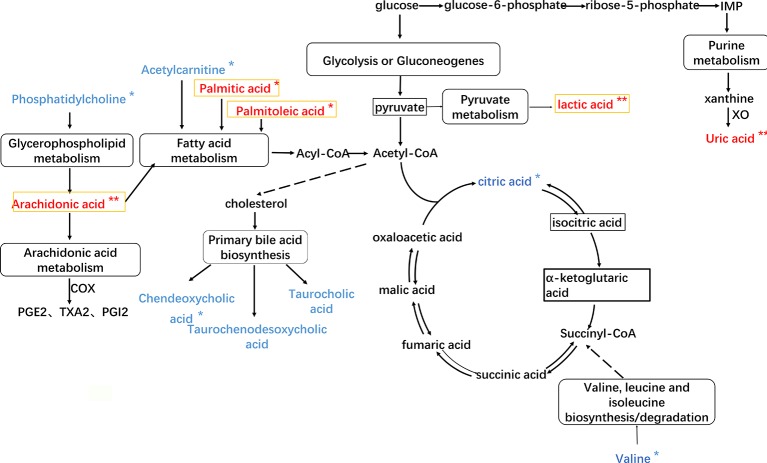
The HF imbalanced network of the metabolic markers in plasma of rat. Metabolites in red and blue represent increase and decrease changes in HF rats; metabolites in yellow rectangle represent validation by MALDI-MS.  Direct interaction,  Indirect interaction, ** p < 0.01, *p < 0.05, YXSC group versus model group.